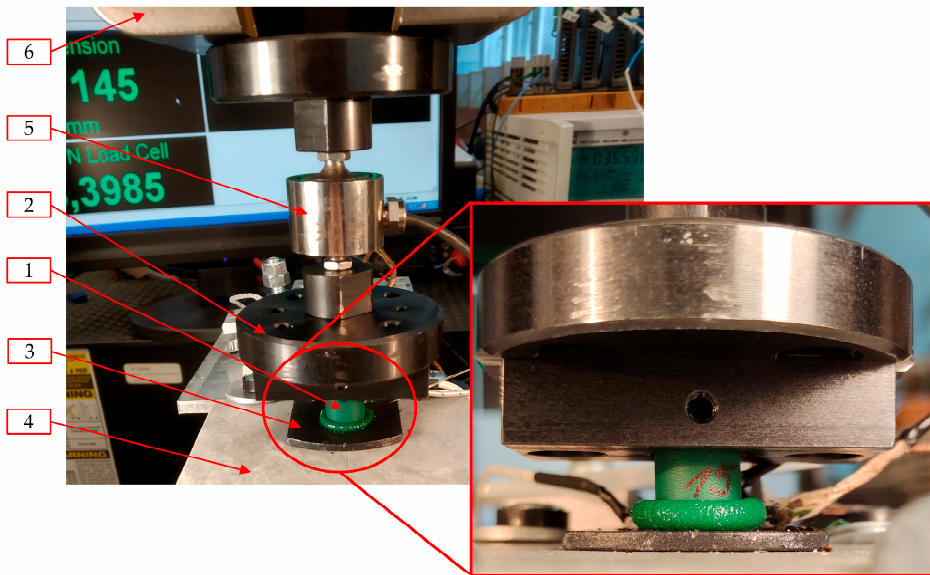
Figure 12. Diagram of the experiment of pressing the belt to the hot plate: 1—belt specimen, 2—specimen holder, 3—hot plate, 4—thermal insulation pad, h —specimen length, h 1 —specimen protrusion distance, v pl —test speed (plasticization velocity).